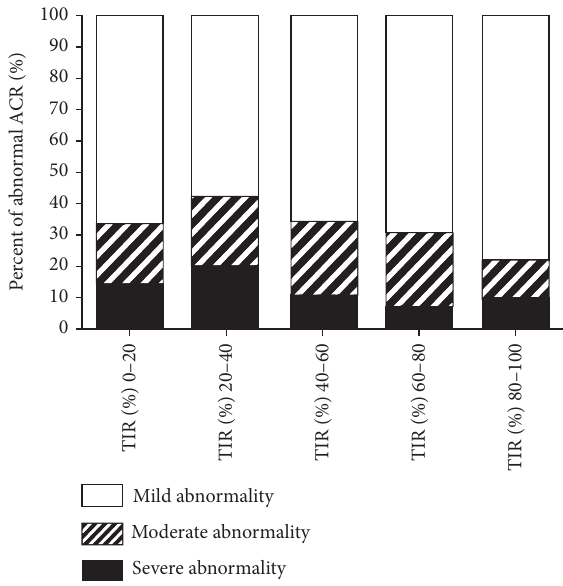
Figure 3: The correlation of TIR with